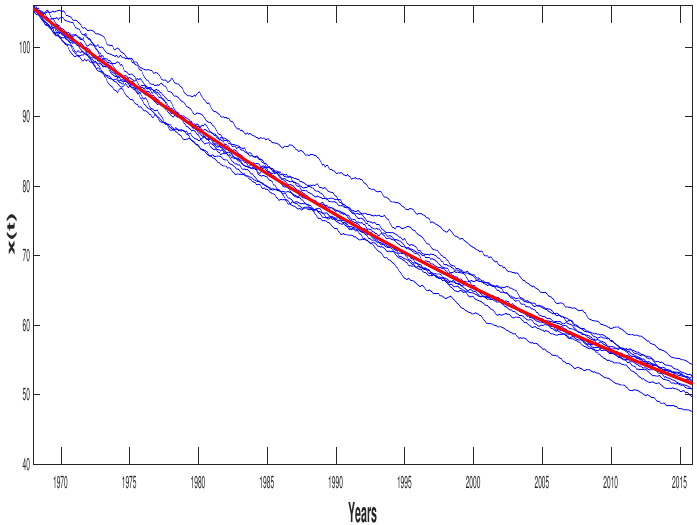
Figure 3. The Stochastic Weibull Diffusion Process (SWDP) simulated with the theoretical trend